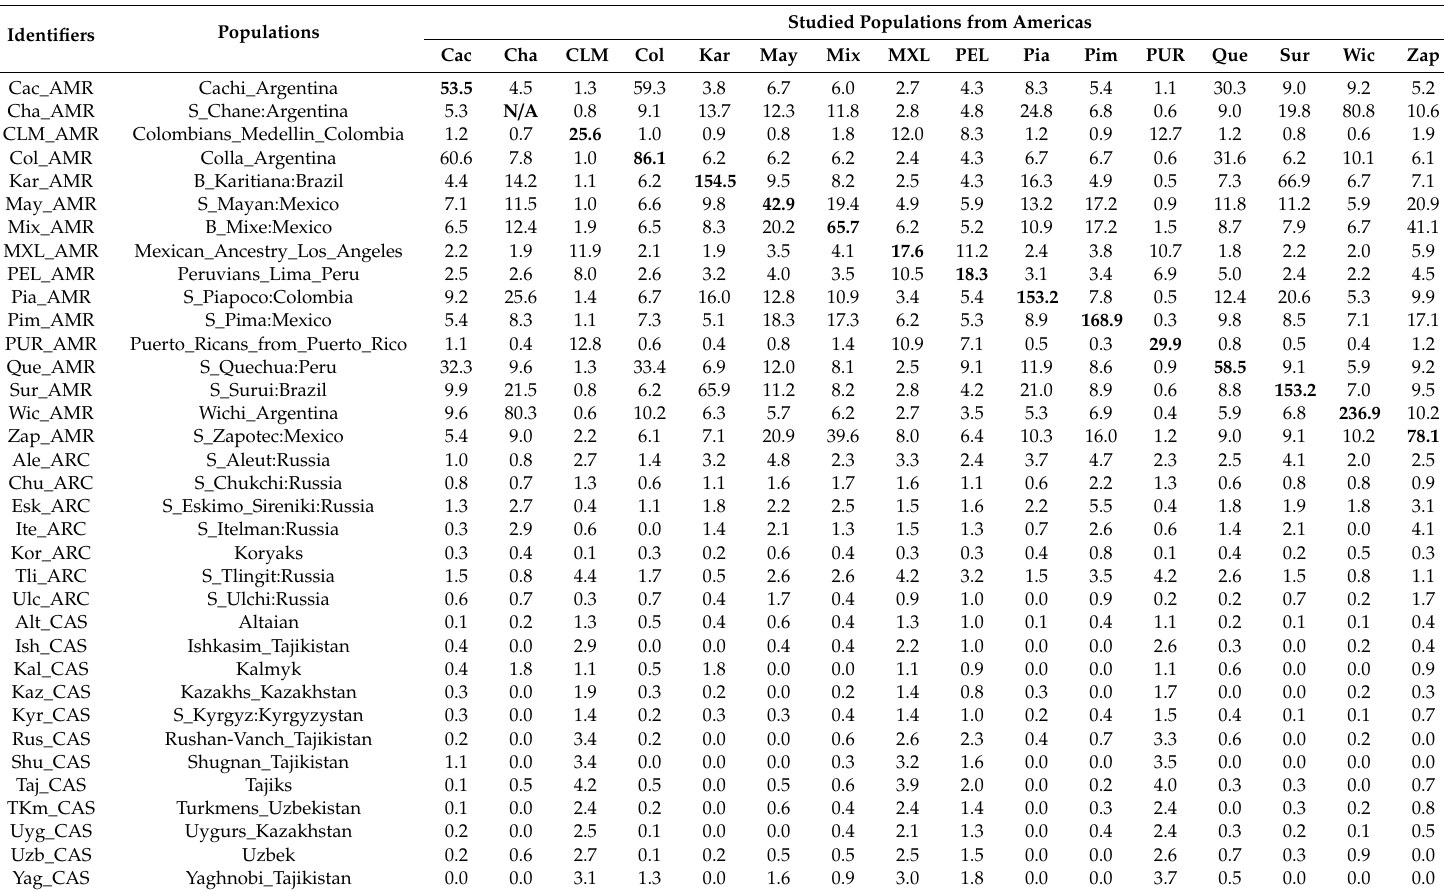
Table 1. Average number of shared identical-by-descent (IBD) segments between